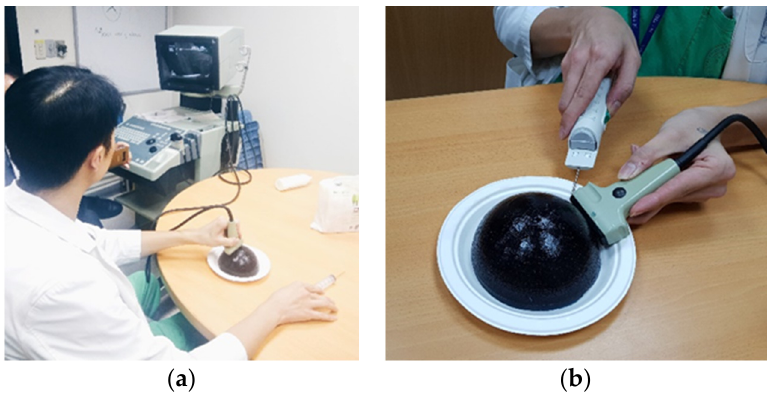
Figure 4. ( a ) Workshop for evaluating the efficiency of the phantom in improving core needle bi- opsy skill of participant. ( b ) Single-layered gelatin-based phantom (glandular tissue embedded with simulated tumors). simulated